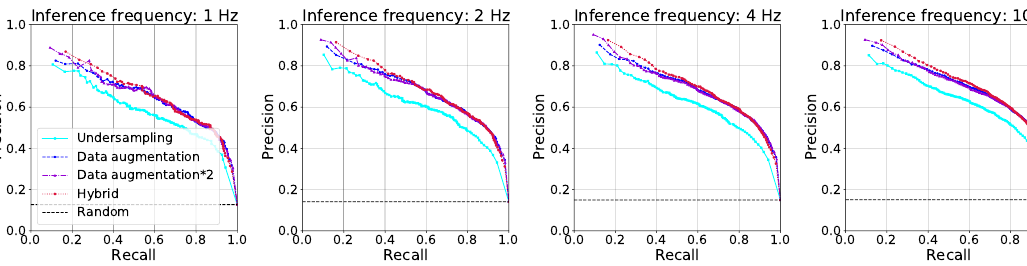
Figure 5. YAMNet Precision–Recall curves comparing each dataset for different inference